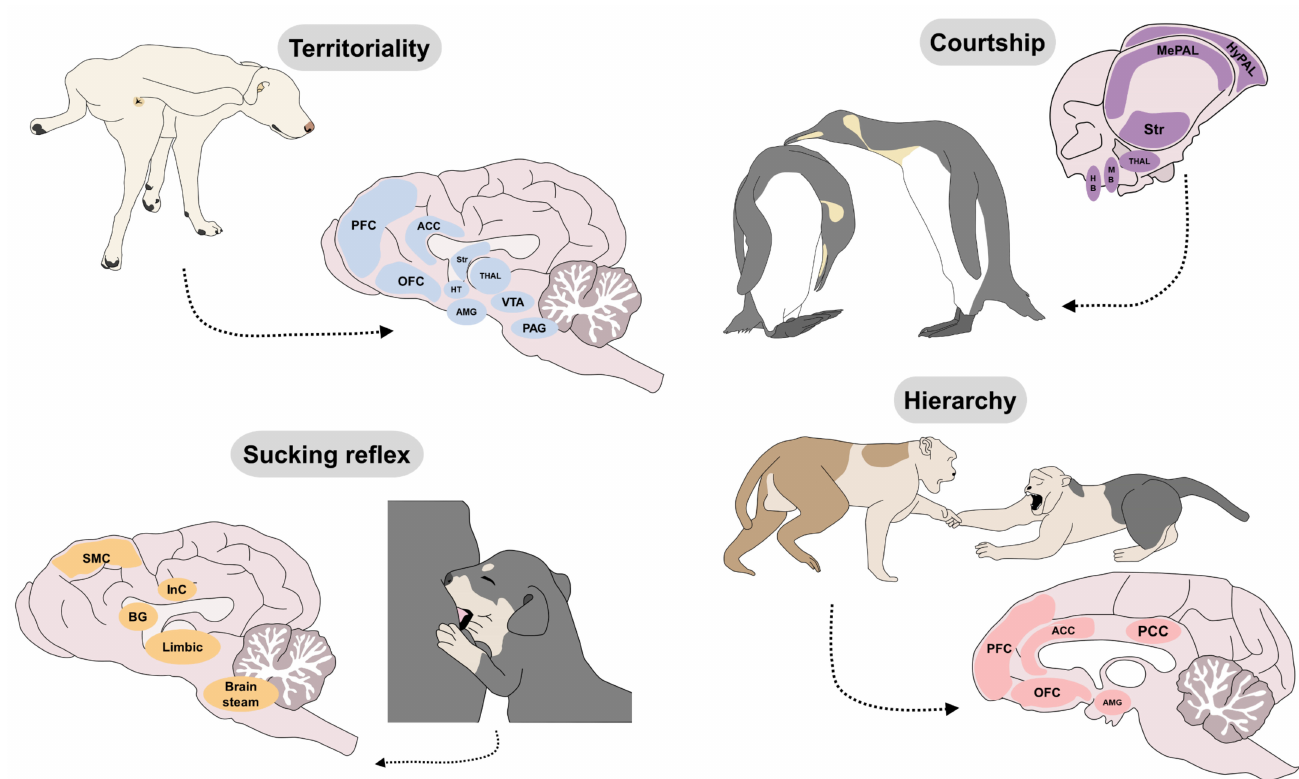
Figure 5. The basic neurobiological systems of behavior evoke developmentally-dependent innate responses. For example, delimiting a territory by marking it with urine reflects the systematic activity of the rage/seeking/lust systems and begins at puberty. Courtship behavior, as in the case of the male penguin that sticks out its chest, raises its beak, and tilts its head back (lust/care systems). The suckling reflex in puppies (seeking, panic) and the establishment of dominance hierarchies in wolf packs (rage/seeking) are other examples. In every innate response, the main cerebral structures involved in the processing of its respective integration is schematized in the brain. ACC: